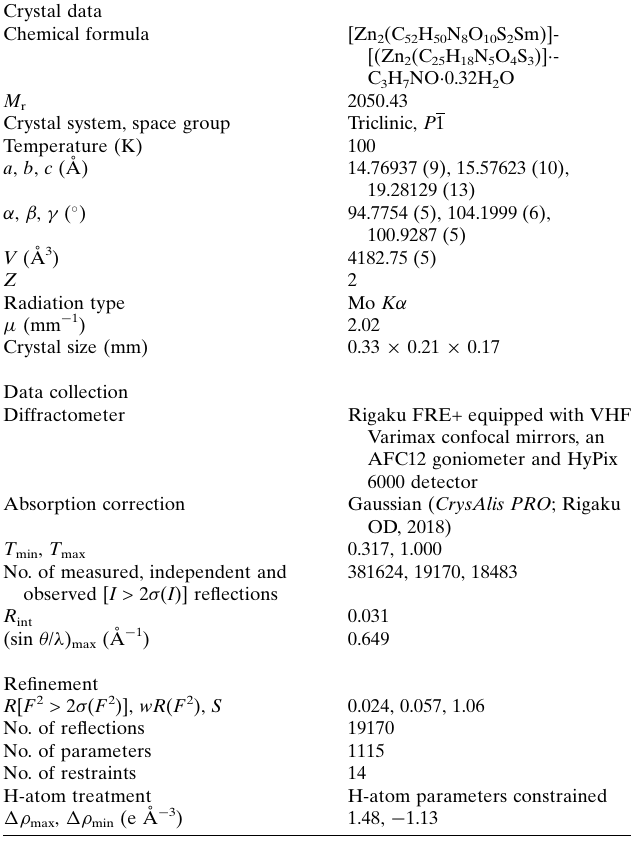
Table 2 Experimental details. Crystal data Chemical